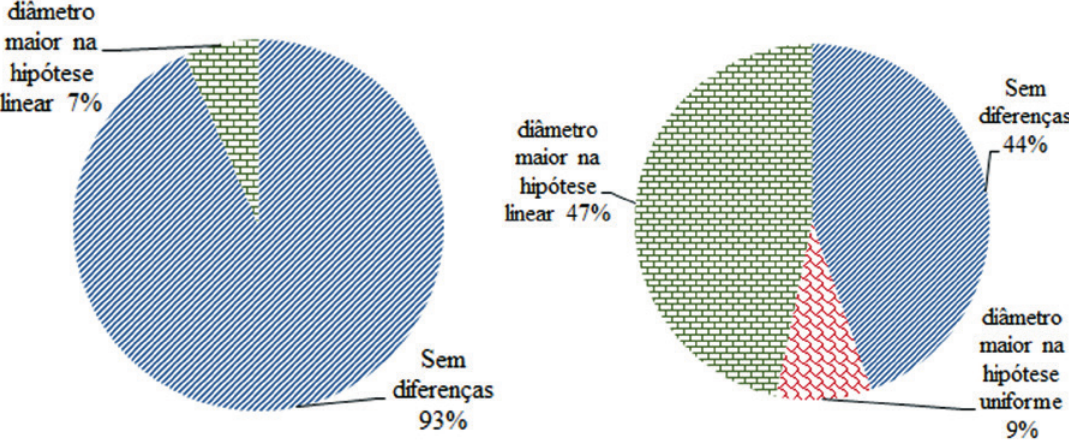
Gráfico da linha de ajuste perfeito para o diâmetro dos chumbadores